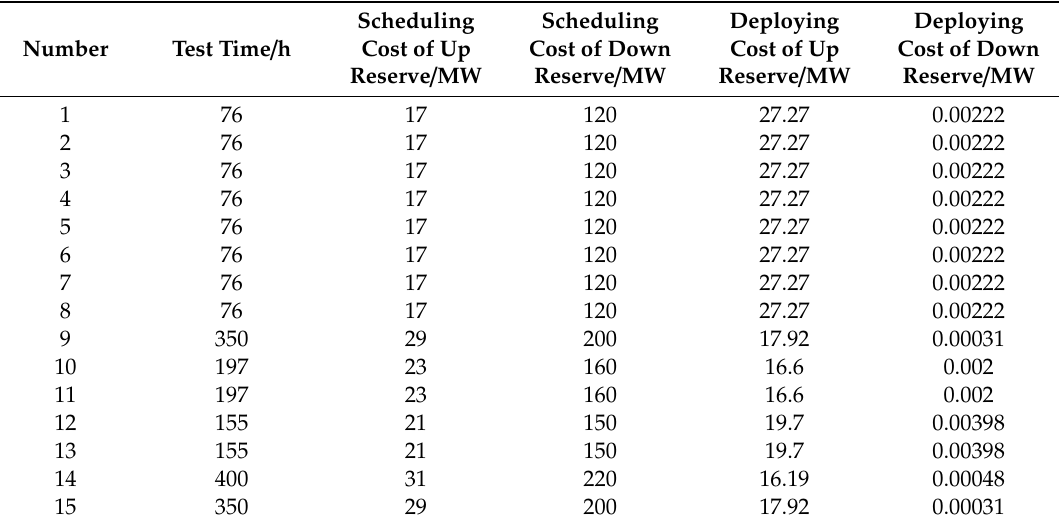
Table A1. Parameters of thermal